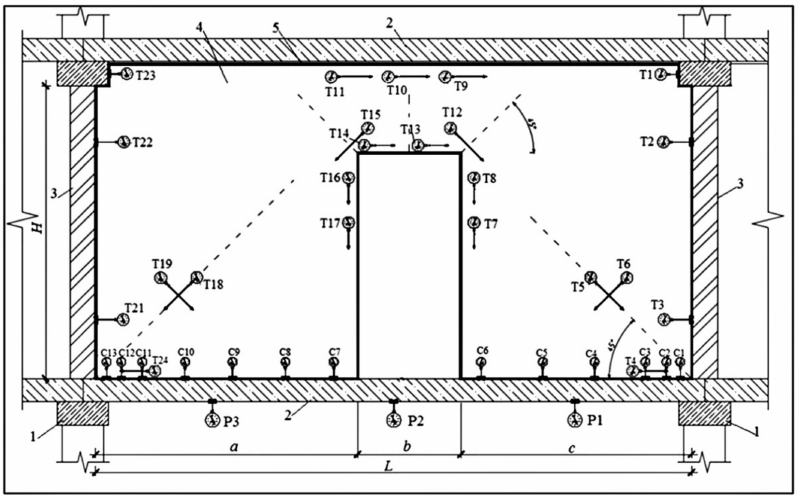
Figure 7. General scheme of the tested partition walls with positioned units for measurements of deformations and relocations: 1—reinforced concrete spandrel beam, 2—multi-channel ceiling slabs made of reinforced concrete, 3—masonry cross walls, 4—partition wall under test, and 5—horizontal expansion joint (T—dial deformation gauges, accuracy to 0.001 mm, C—dial relocation gauges, accuracy to 0.01 mm, P—floor deflection gauges, accuracy to 0.01